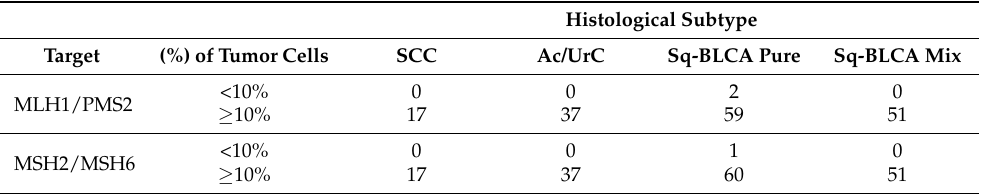
Table 2. Immunohistochemical results of DNA mismatch repair (MMR) proteins in histological subtypes of bladder cancer.